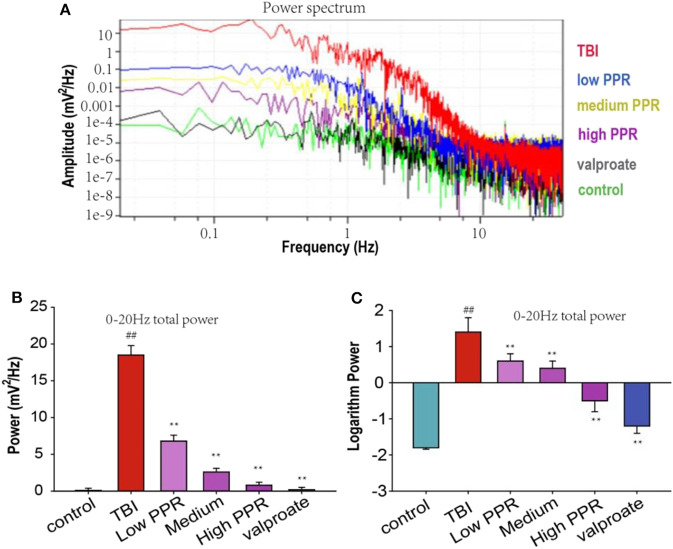
Effect of piperine on the total brain discharge in mice with epilepsy after a traumatic brain injury (TBI). **p < 0.01 vs. the TBI group; ##p < 0.01 vs. the control group. (A) The upper panel shows the power spectrum of electroencephalogram (EEG) in the five groups. The lower panels (B,C) shows the analysis of the powers of EEG in the five groups (**p < 0.01).